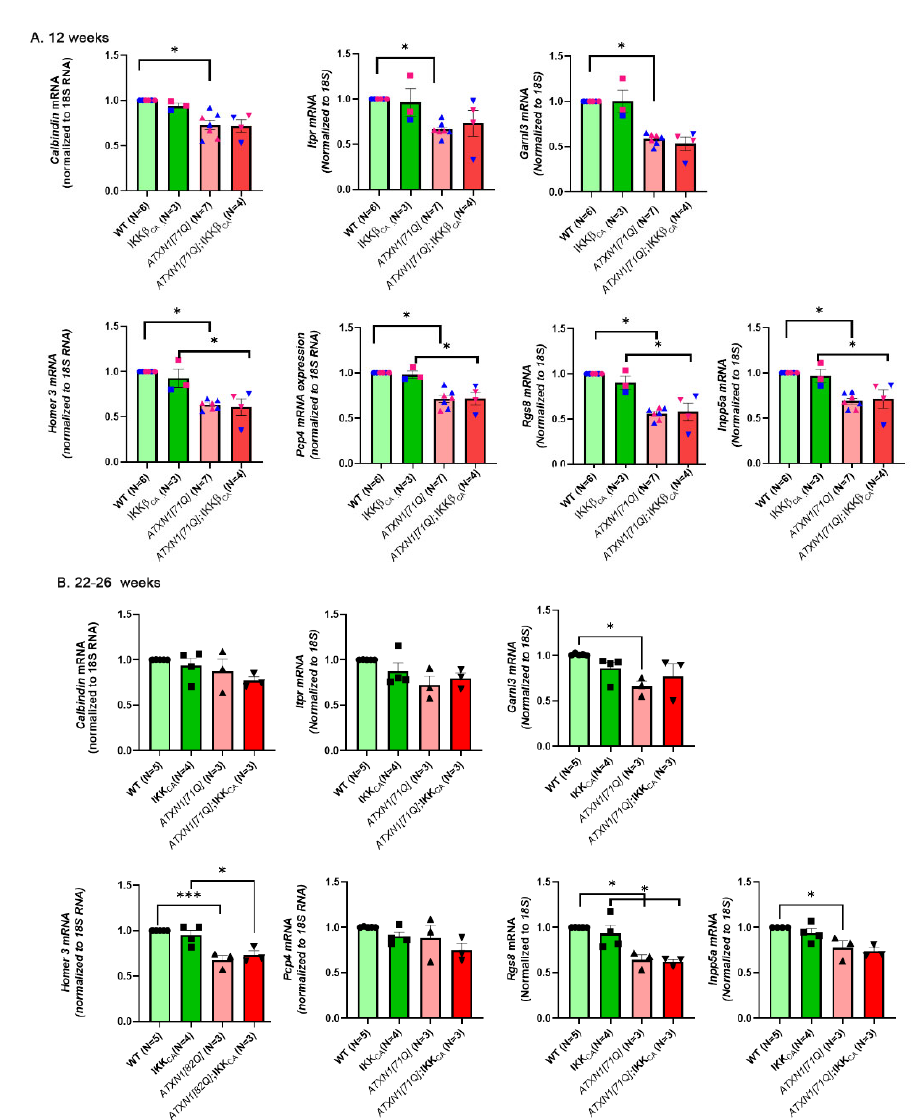
Figure 6. Expression of Purkinje cell genes associated with SCA1 disease is decreased in ATXN1[71Q] mice. The cerebellum was dissected from 12- and 22–26-week-old mice, mRNA was extracted, and RT-qPCR was used to evaluate expression of Purkinje cell genes associated with SCA1 disease. Data are presented as mean ± SEM with average values for each mouse represented by a dot. * p < 0.05, *** p < 0.0005 using one-way ANOVA with Bonferroni’s multiple comparison test. Error bars =